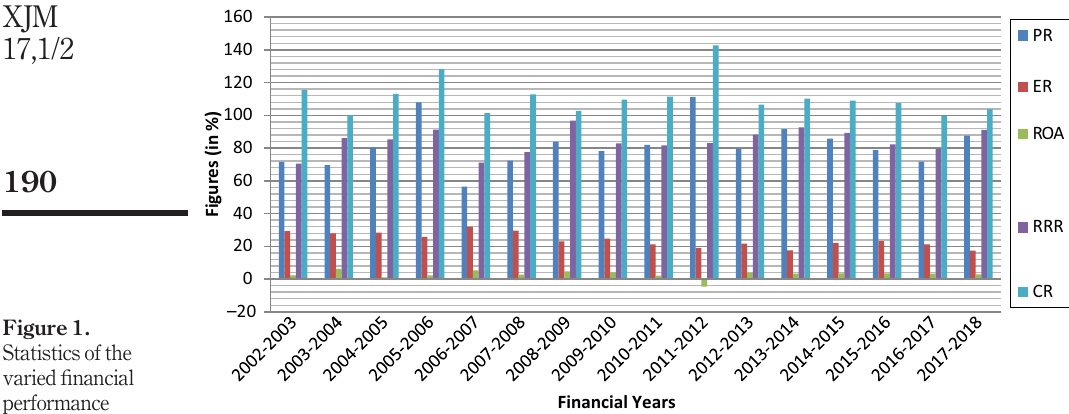
Authors own presentation using data from Table 2